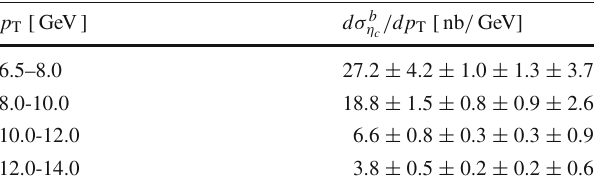
Table 8 The p T -differential η c production cross-section in inclusive b -hadron